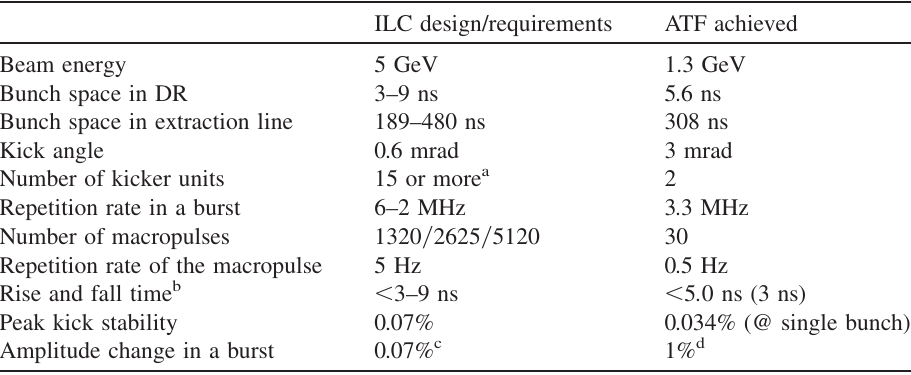
TABLE I. Parameters of the ILC-DR kicker and parameters achieved at